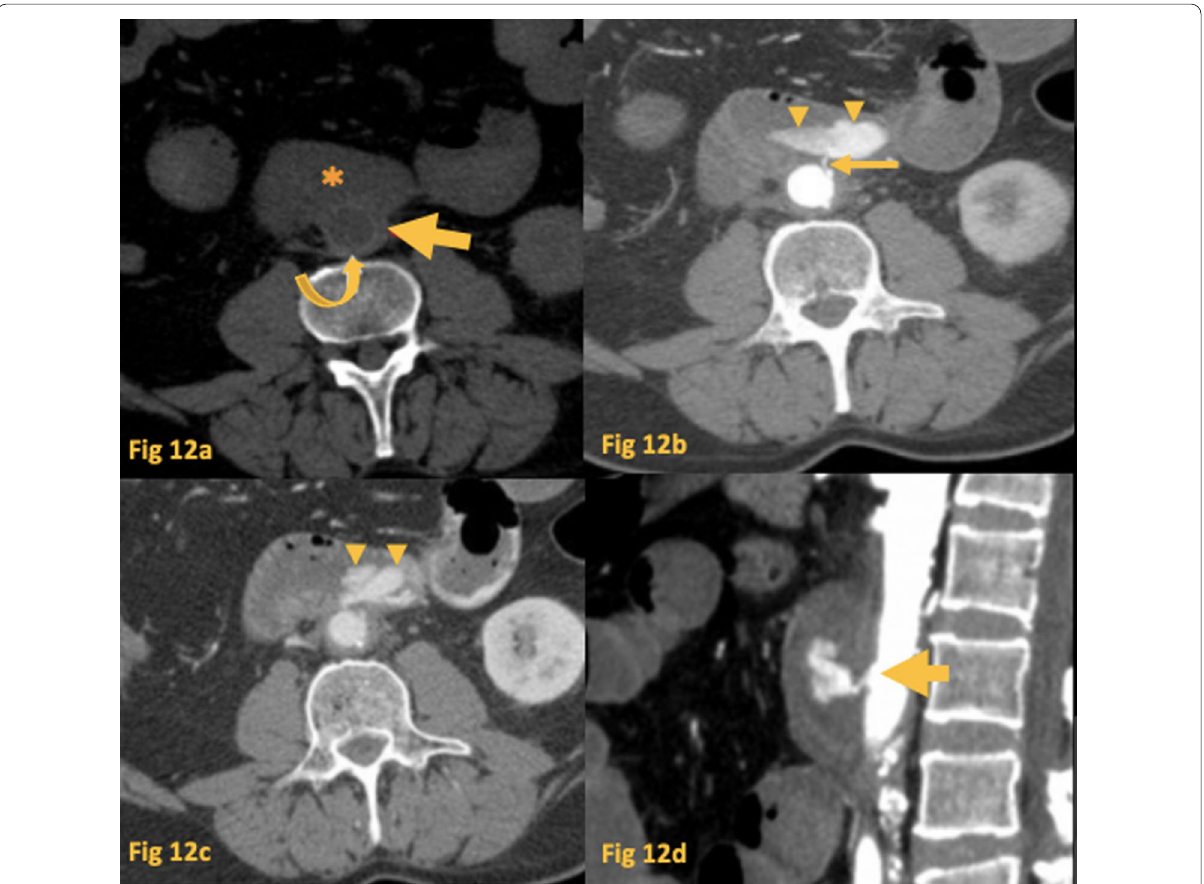
Fig. 12 Fistula (Aorto‑duodenal). Unenhanced CT ( a ) of patient with hematemesis shows an aorto‑bi‑femoral stent (curved arrow) inside the infra‑renal aorta, with exclusion of atherosclerotic plaque (arrow), in close proximity to the third part of the duodenum (asterisk). Arterial phase CT (MIP) ( b ) shows an aortoduodenal fistula (arrow), with blood leaking into D3 (arrowheads) in the topography of the proximal end of the aortic stent. Portal phase CT ( c ) shows increased pooling of blood in the duodenum and jejunum (arrowheads). Sagittal reformat in arterial phase CT ( d ) better shows the fistulous tract of the blood into D3